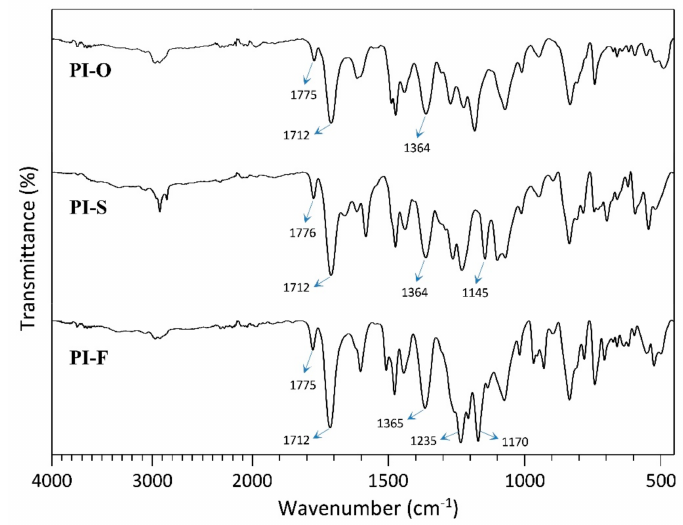
Figure 2. FT-IR spectra for the